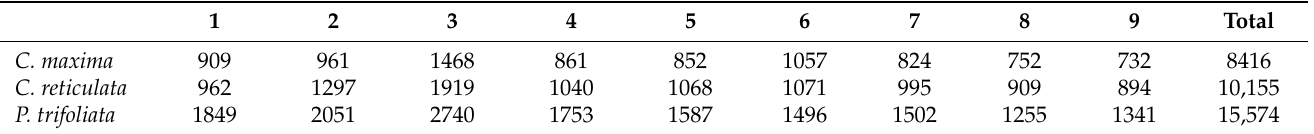
Table 2. Number of DSNP for the three ancestors on the nine chromosomes.